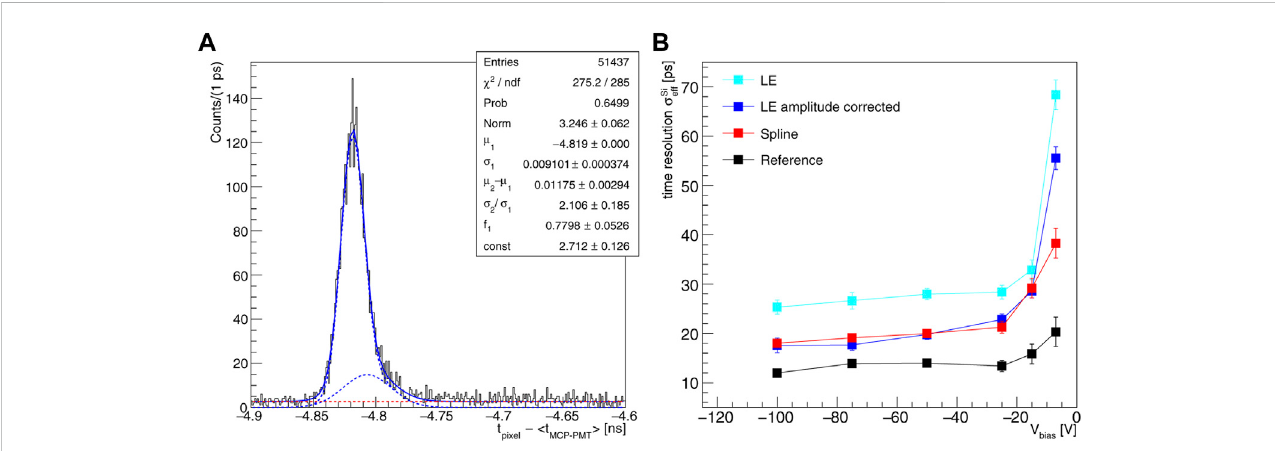
FIGURE 9 (A) Distribution of the difference between the TOA of the single pixel and the time reference, t pixel — 〈 t MCP-PMT 〉 , for the single pixel at V bias = − 100 V with the reference method. The distribution is fi t with the sum of two Gaussian functions (blue dashed lines) describing the signal, and a constant (red dashed line) modellingthebackground. (B) Effectivetimeresolutionofthesinglepixelatdifferentbiasvoltagesfordifferentanalysismethods.Herethecontributiondueto the resolution of the time reference is subtracted.